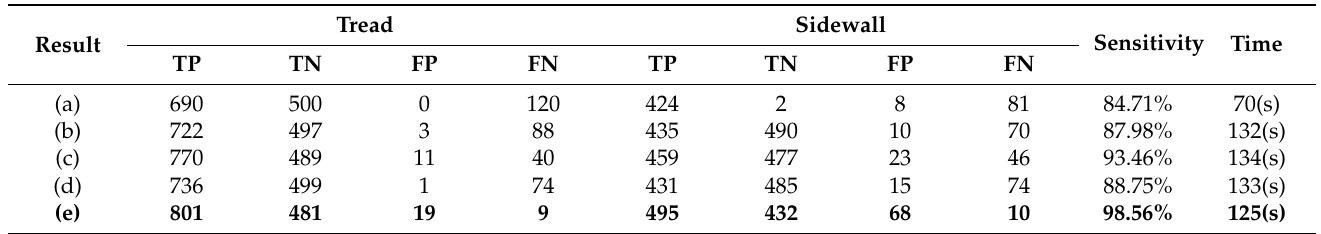
Table 9. Results and detection times of the incremental YOLO architecture with different